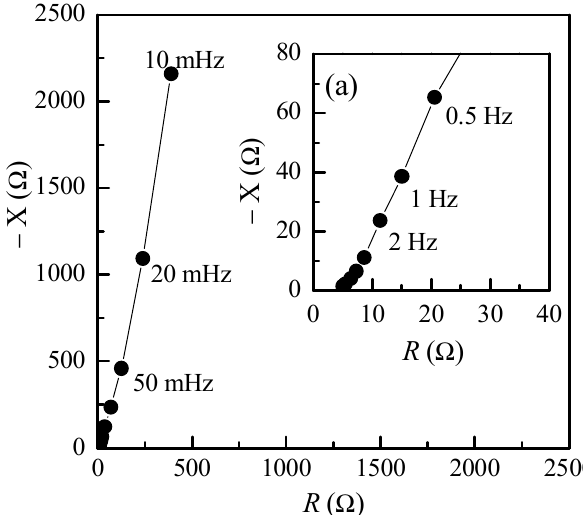
Figure 13. Nyquist plot from the low frequency impedance data in Figure 12. Due to the large dynamic of the data on a linear scale, a magnified view of the data at higher frequencies is reported in the inset (a).